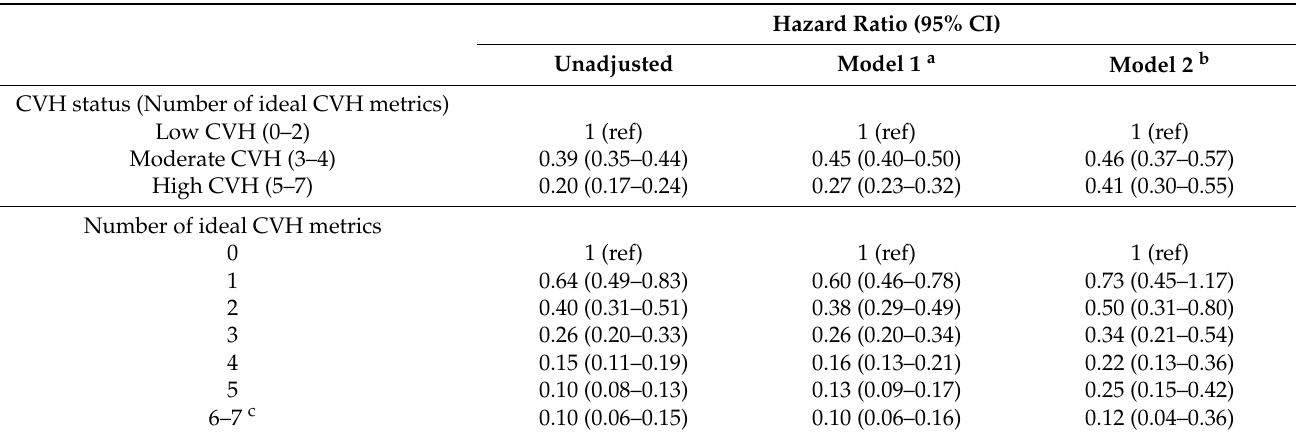
Table 3. Hazard ratio for the incident proteinuria between different CVH statuses and different number of ideal CVH